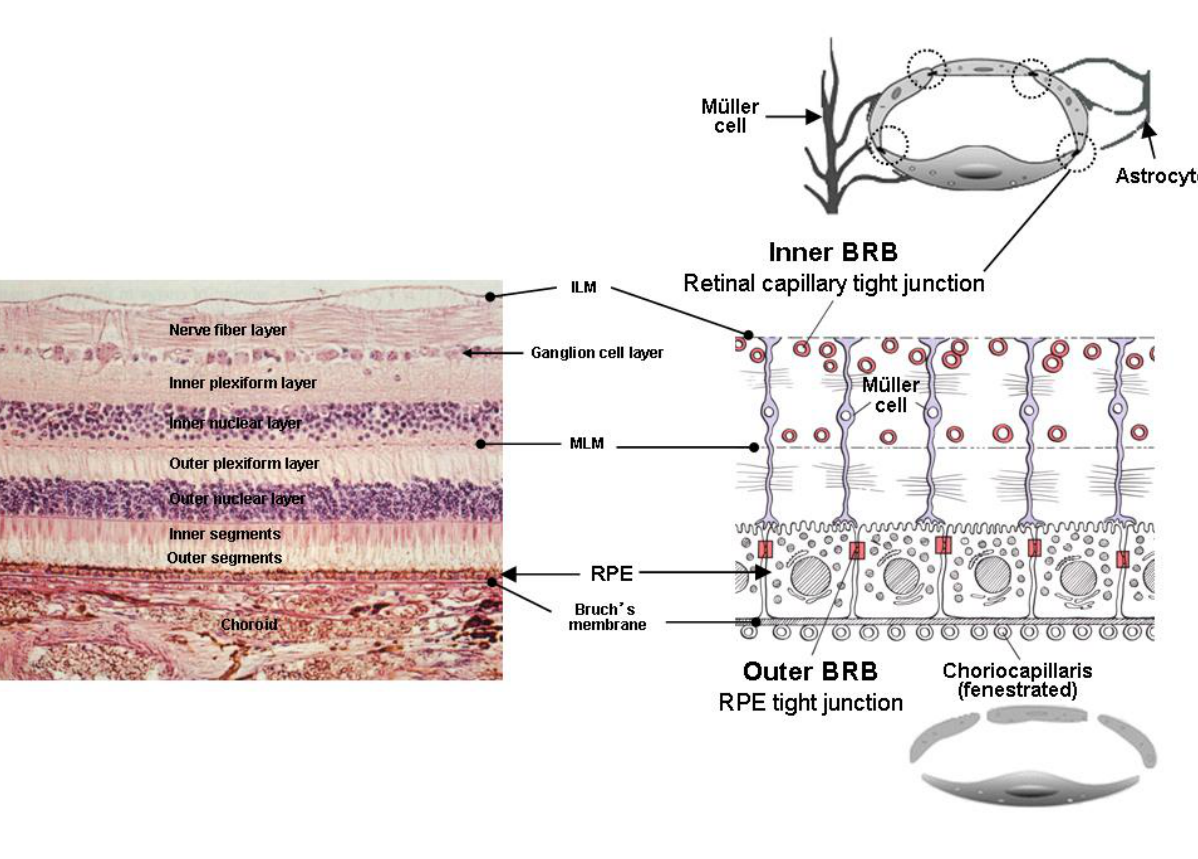
Figure 5. Schematic of blood-retinal barrier, and capillary wall in the retina and the